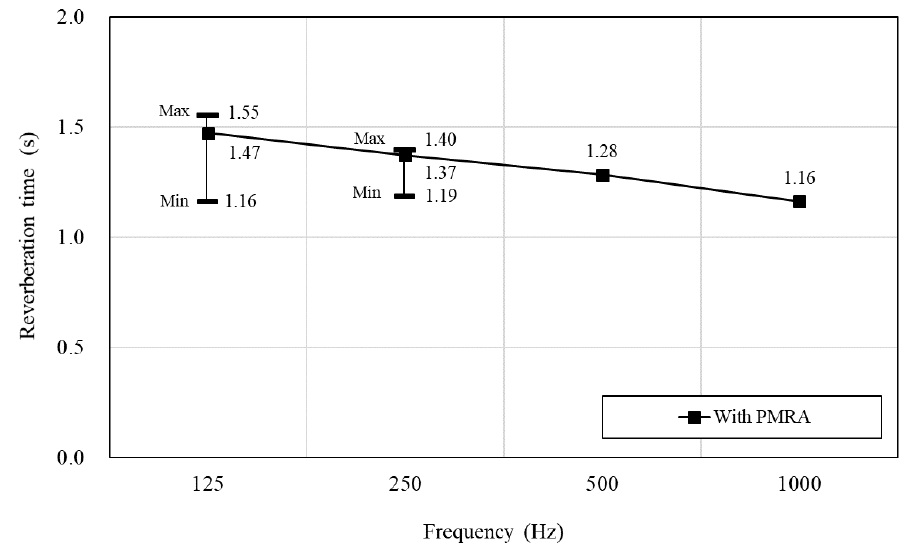
Figure 16. RT of Ge-Chi Hall with PMRA.